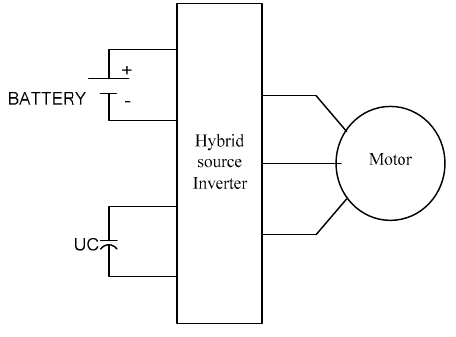
Figure 11. UC/battery with inverter design. Figure 11. UC / battery with inverter